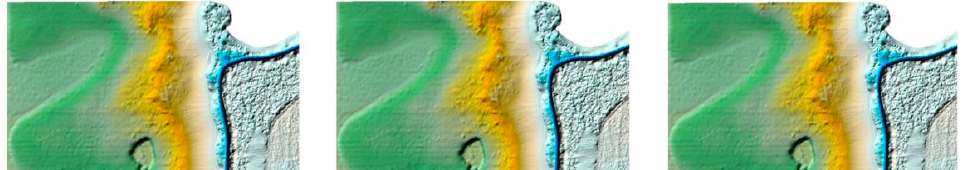
Figure 20. Combination of models constructed by nearest neighbor ( left ), bilinear interpolation ( middle ), and cubic convolution ( right ) method.